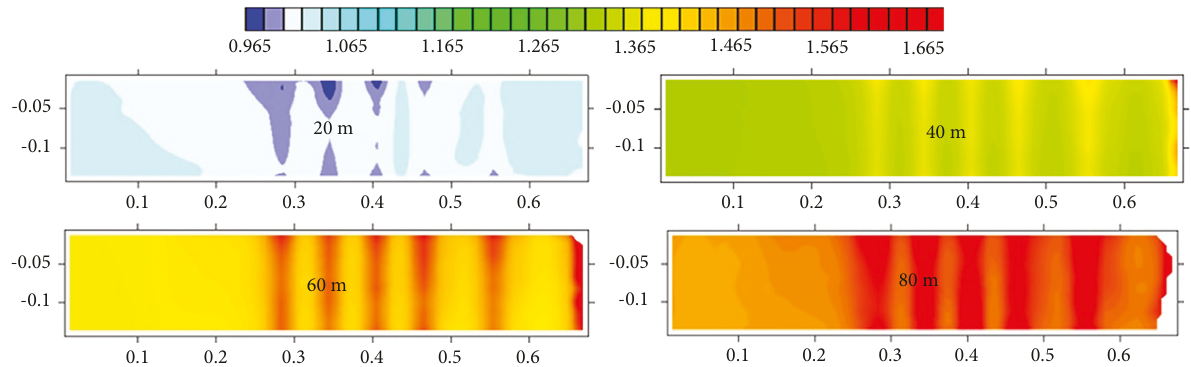
Figure 21: The resistivity section ratio chart in the x - z plane at 15cm above the coal seam ( y